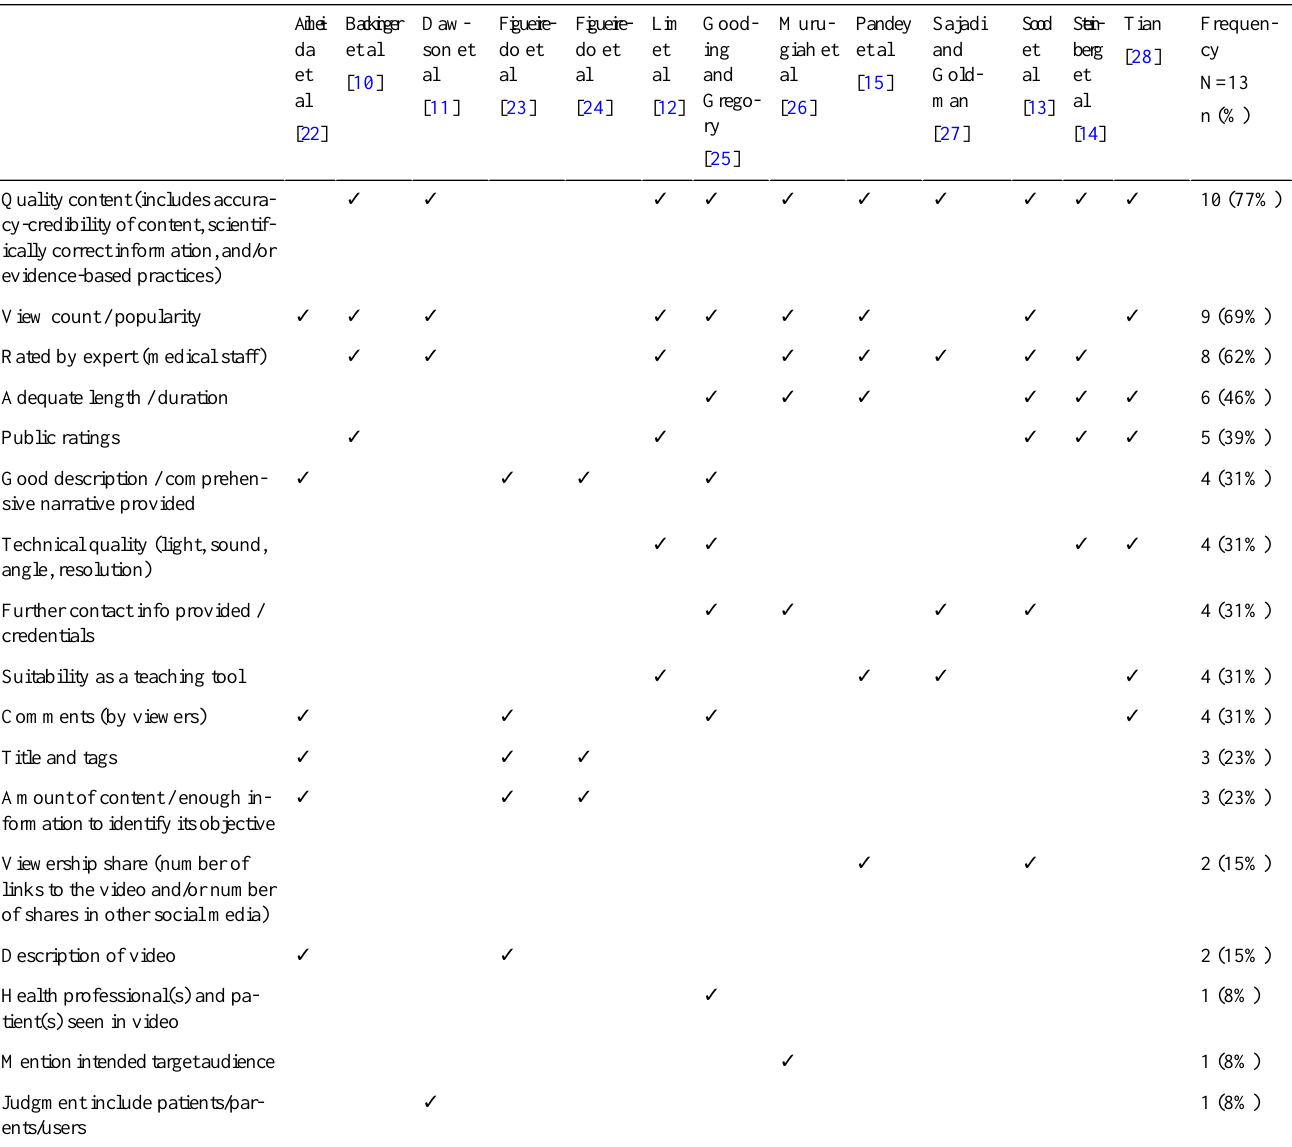
Table 1. Topics linked to quality of information for patient education on